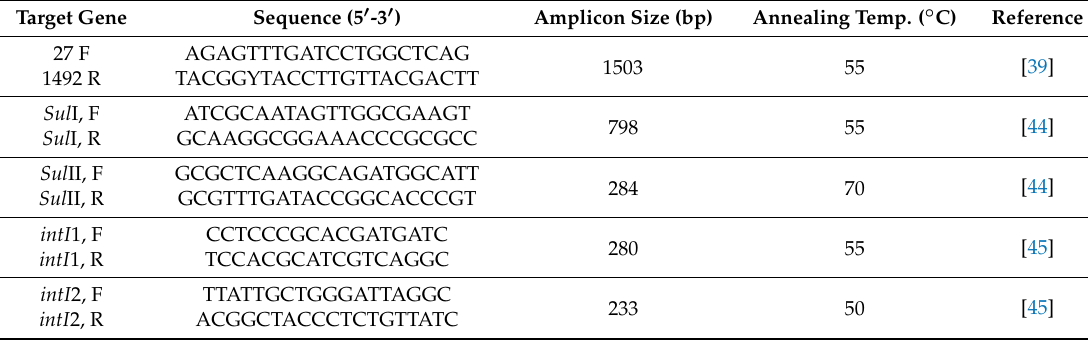
Table 1. Primers and conditions used to amplify 16S rRNA genes, sul genes, class 1 and 2 integrons by PCR